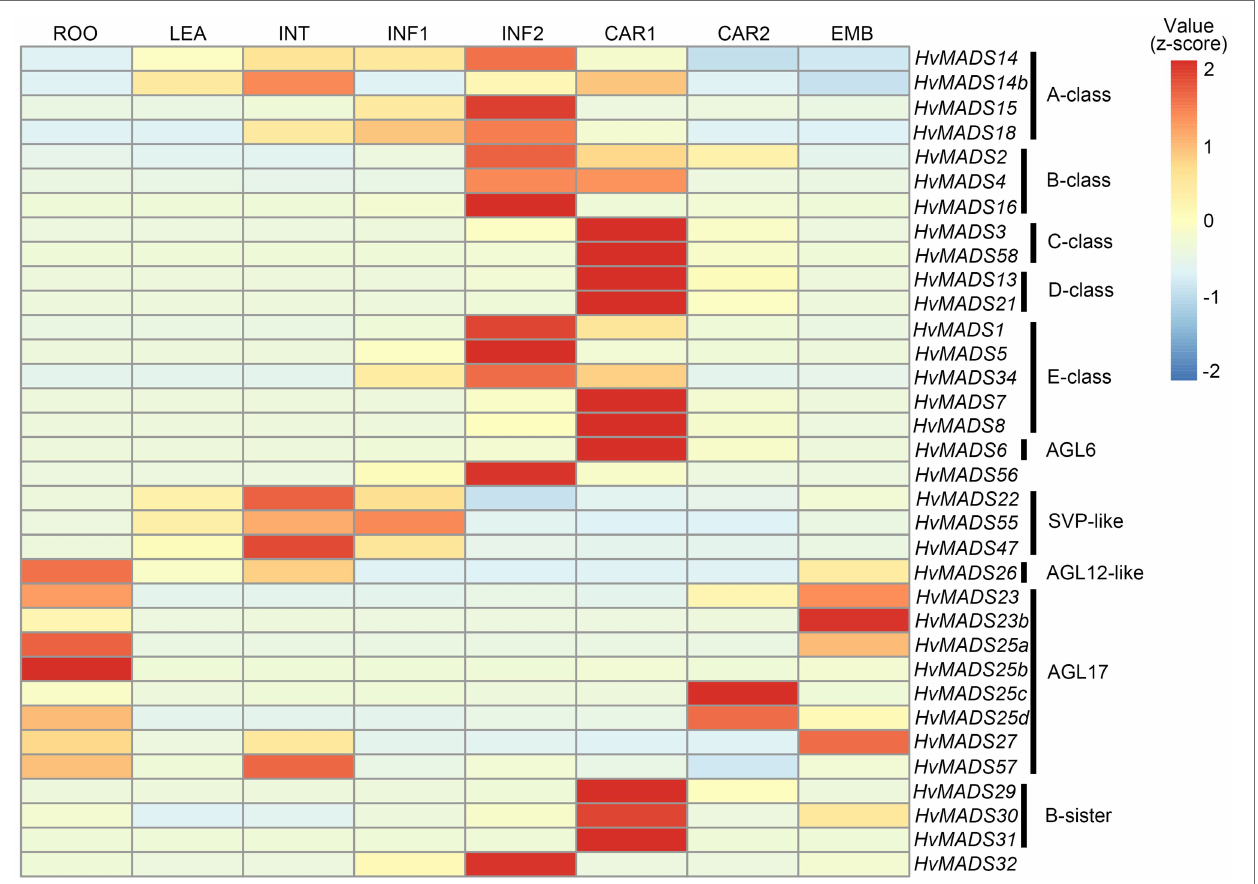
FIGURE 2 | Hierarchical clustering analysis of MIKCc genes’ global transcript in different barley tissues. RPKM (Reads Per Kilobase Million) is normalised using a pheatmap package in R. ROO, roots 17 days after planting (DAP); LEA, leaves 17 DAP; INT, third internode 42 DAP; INF1, developing inflorescence 5 mm (about 30 DAP); INF2, developing inflorescence 10–15 mm (about 50 DAP); CAR1, developing grain 5 days after anthesis (DAA); CAR2, developing grain 15 DAA; and EMB, embryo 4 days after germination. Raw data from Mayer et al.